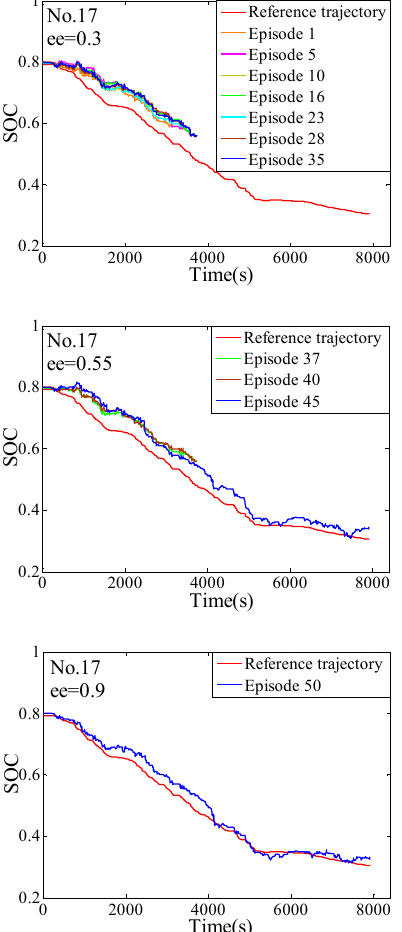
Figure 16. The training process of combined driving cycle 17.